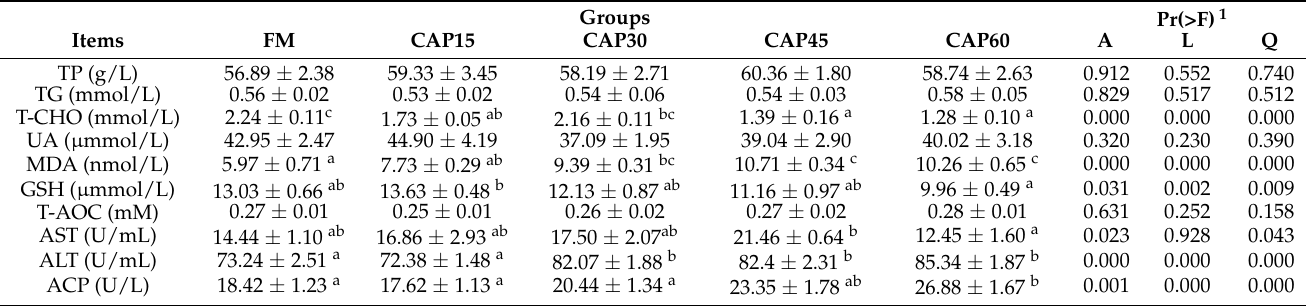
Table 5. Serum biochemical indices and enzyme activities of pearl gentian grouper-fed gradient substitution of fishmeal in the diet with